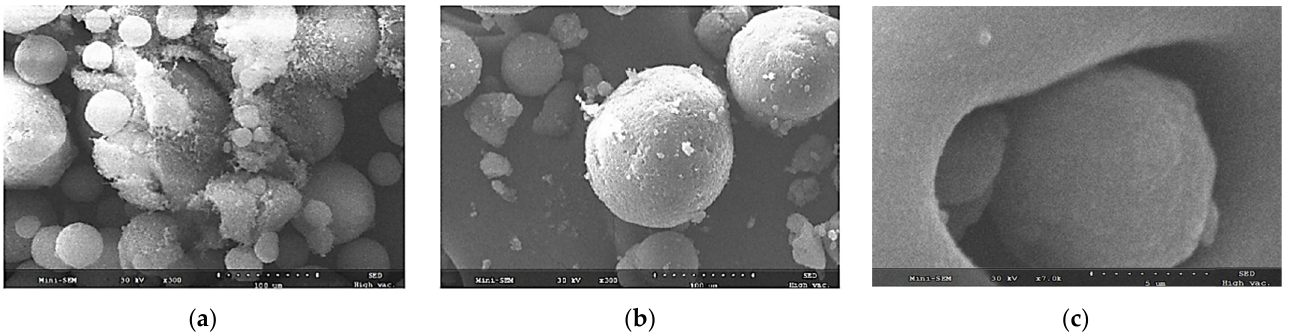
Figure 2. Scanning electron microscopy (SEM) micrographs showing the morphology of ( a ) physical mixture at 300 × magnification; ( b ) NSC-03 at 300 × magnification; and ( c ) NSC-03 at 7000 × magnification.